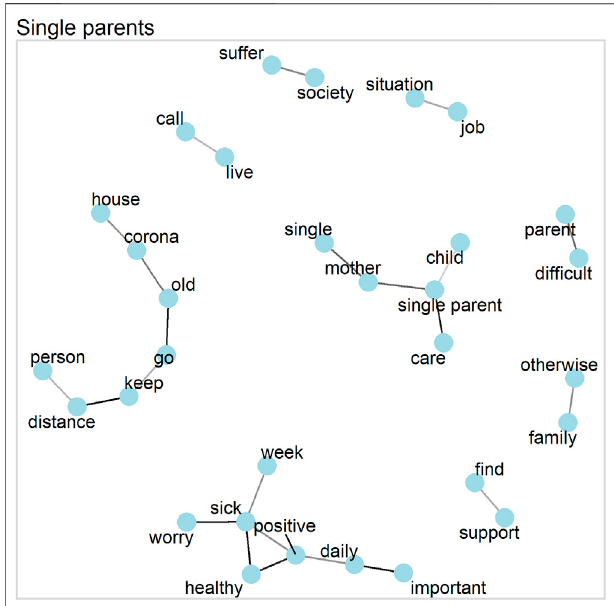
FIGURE 1 | Word network for single parents (correlations > 0.5).